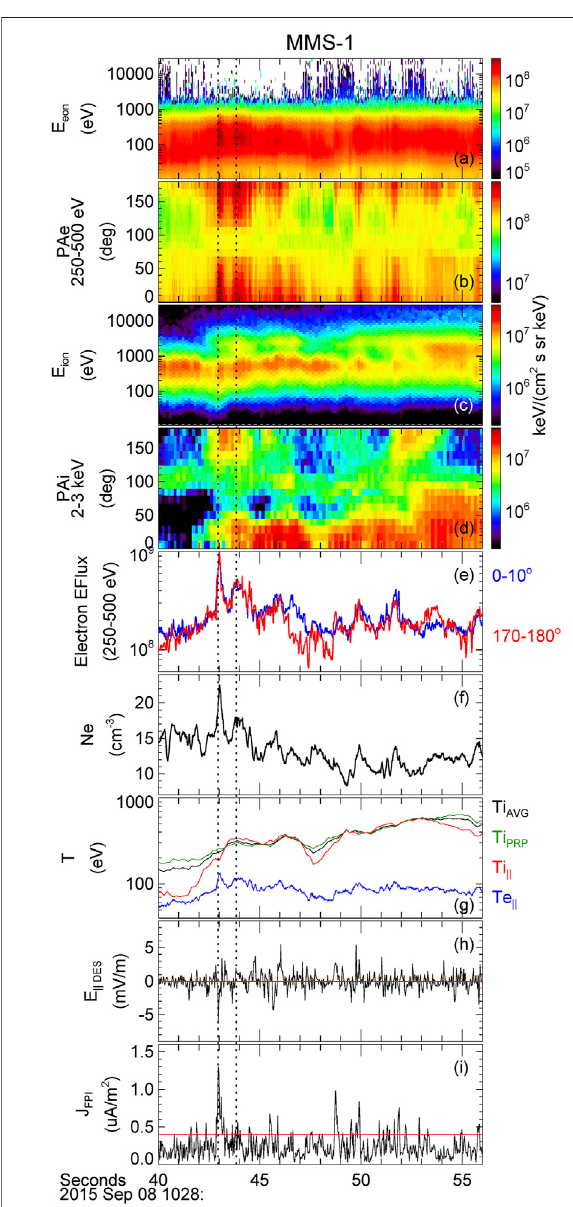
FIGURE9| MMS-1burstobservationsfrom1029:42UTto1030:01UT. Panels show the same parameters as in Figure 8 . The vertical dotted lines mark the time period from 1029:51.849 UT to 1029:55.900 UT associated with counter-streaming of Ne (cid:1) 6.2 cm − 3 (54% reduction) and Ne (cid:1) 8.2 cm − 3 (39% reduction), respectively. In fact, Ne correlates very well with the energy fl ux of bi-directional 250 – 500 eV electrons across most of the 19-s period. Figure 9A indicates a presence of 3 – 10 keV high- energy electrons centered at both E f depletions. These observations suggest how the fi rst two depletions of the bi- directional electron energy fl ux may be associated with a